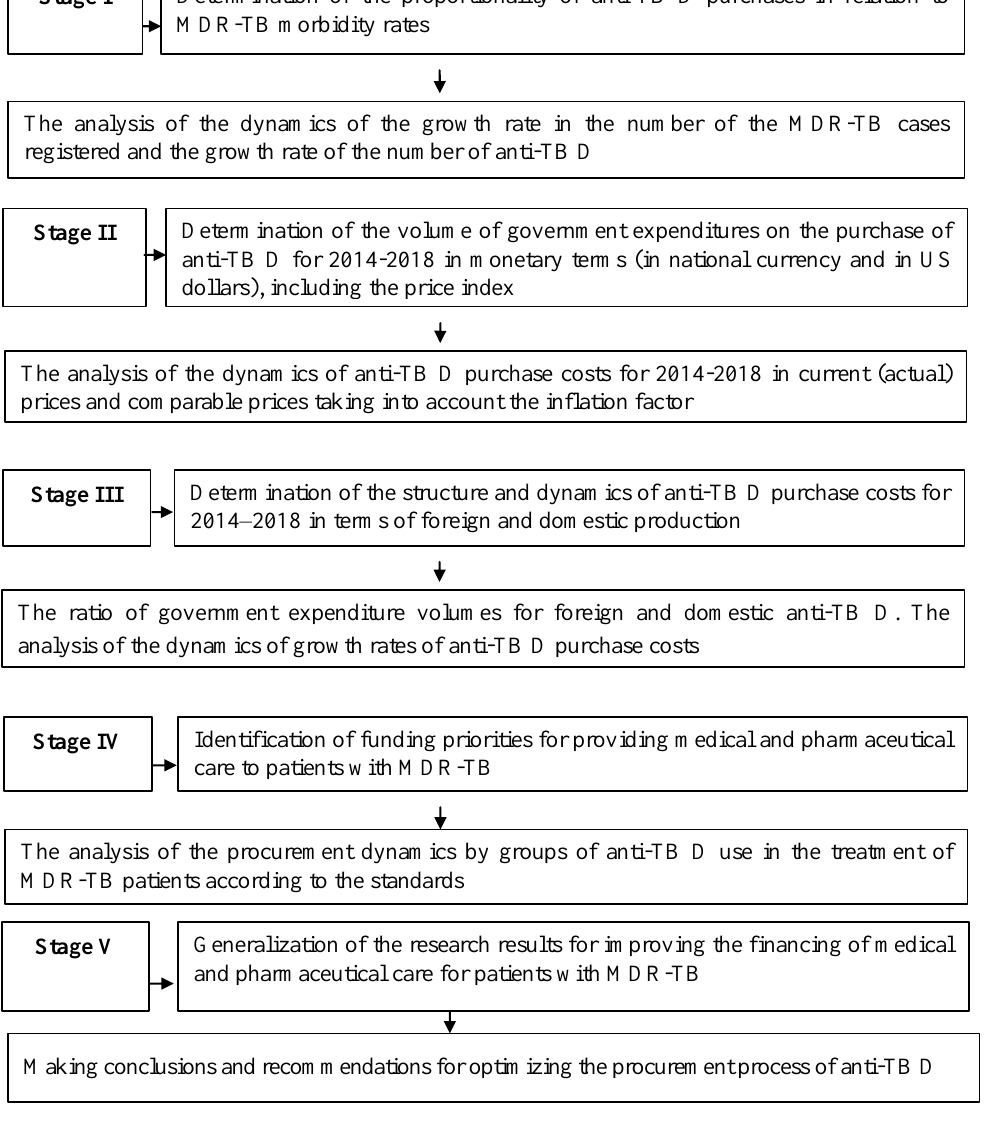
Fig. 1. The algorithm for analyzing the volume of government expenditures on the purchase of anti-TB D for